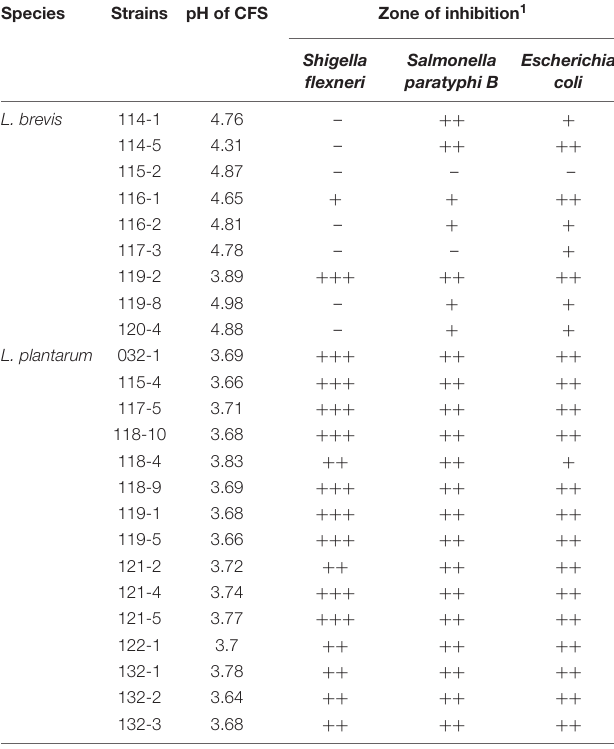
TABLE 3 | Antimicrobial activity of the cell-free supernatants of Lactobacillus strains from fermented vegetables in Shaanxi,